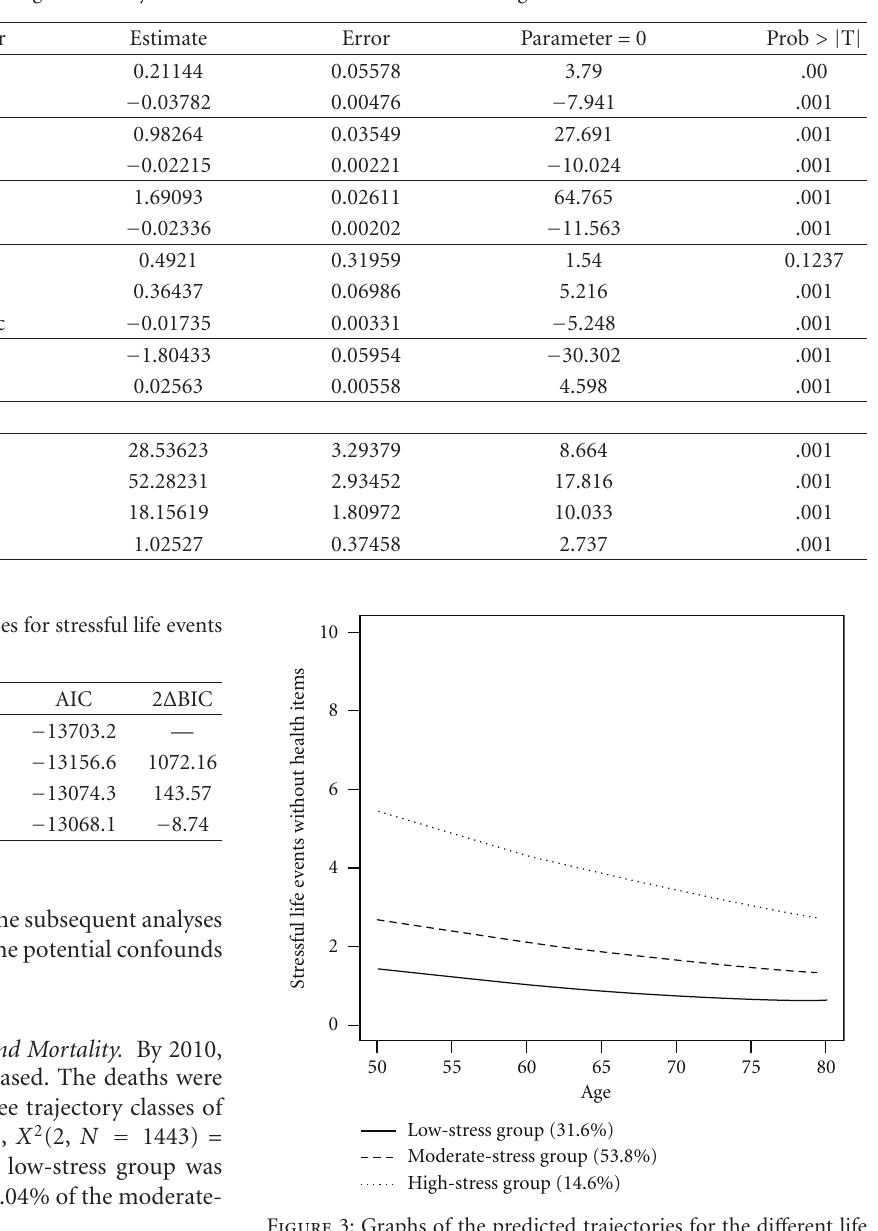
Table 2: Latent class growth analysis results for stressful life events including health items.